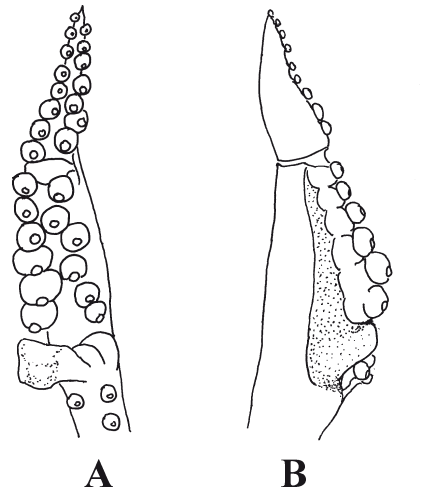
Fig . 7. – Diagram of Sepiola bursadhaesa n. sp. hectocotylus (left arm I of mature male). A, oral view; B, inner lateral view.